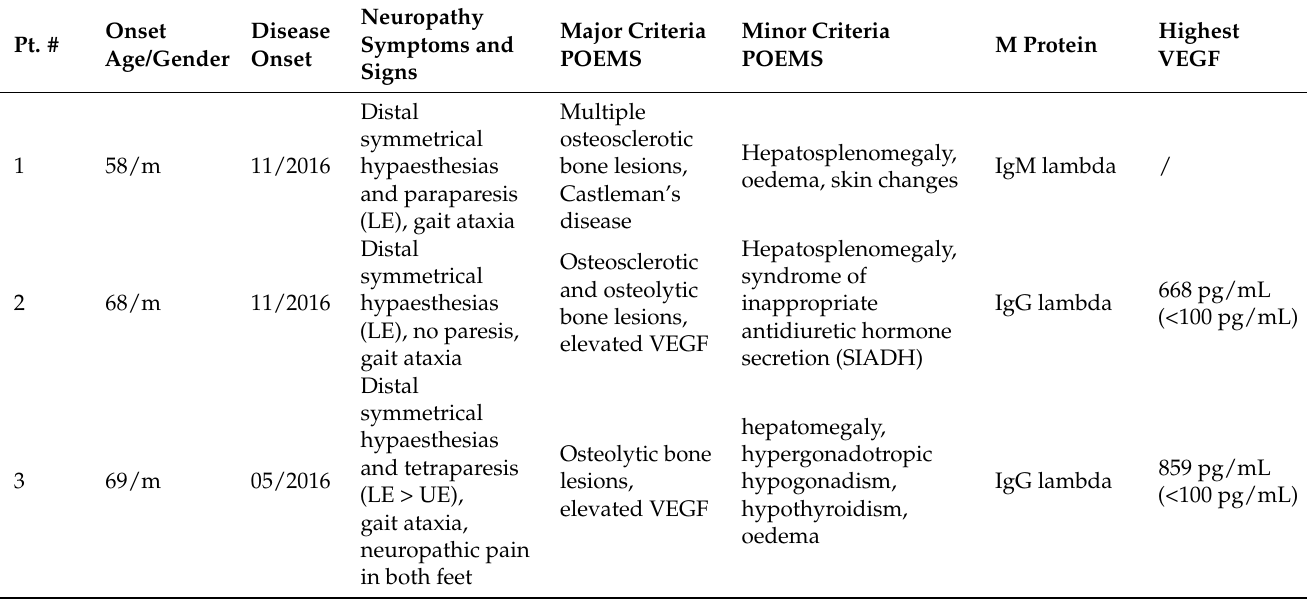
Table 1. Characteristics of patients with POEMS syndrome (polyneuropathy, organomegaly, endocrinopathy, M-protein, skin changes).